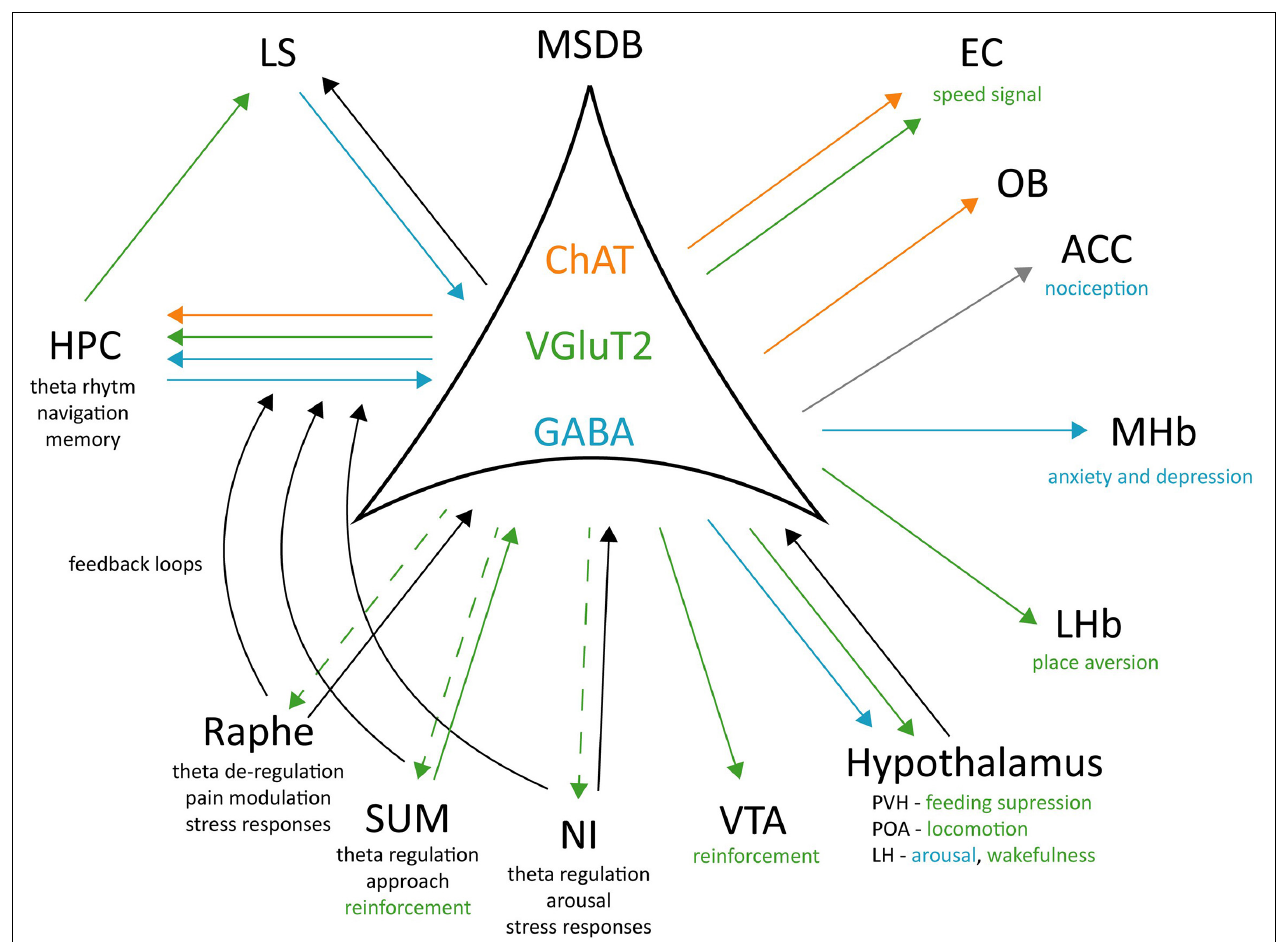
FIGURE 2 | Cell-type specific connectivity of the MSDB. MSDB ChAT, VGluT2, and GABA neurons project to different brain regions and differently contribute to specific behaviours. Green arrows: VGluT2 projections; Blue arrows: GABAergic projections; Orange arrows: ChAT projections; Gray arrow: polysynaptic input; Black arrows: unspecified neurotransmitter; Dashed arrow: unknown physiological role of the projection. ChAT, Choline acetyltransferase; VGluT2, Vesicular Glutamate Transporter 2; GABA, Gamma aminobutyric acid; EC, Entorhinal Cortex; OB, Olfactory Bulb; ACC, Anterior Cingulate Cortex; MHb, Medial Habenula; LHb, Lateral Habenula; PVH, Posterior Ventral Hypothalamic nucleus; POA, Preoptic Area; LH, Lateral Hypothalamus; VTA, Ventral Tegmental Area; NI, Nucleus Incertus; SUM, Supramammillary Nucleus; LS, Lateral Septum; Hippocampus,